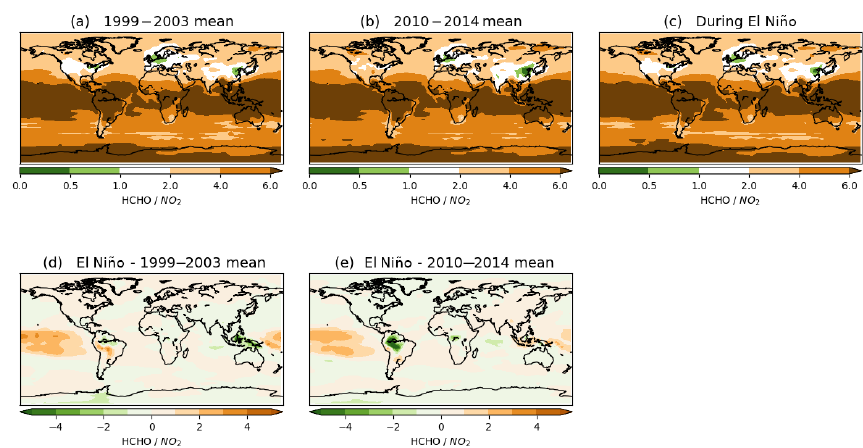
Figure 8. Mean ratio of simulated tropospheric column HCHO to NO 2 amounts for (a) the beginning of model period (1999–2003), (b) the end of model period (2010–2014) and (c) during all El Niño events. Panels (d, e) show the difference during El Niño from the 5-year mean values in panels (a, b) , respectively.